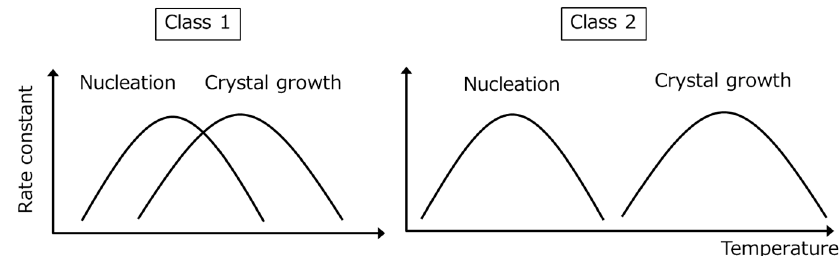
Figure 4. Schematic representation of the temperature dependence of the nucleation and crystal growth temperatures for Classes 1 and 2 compounds.